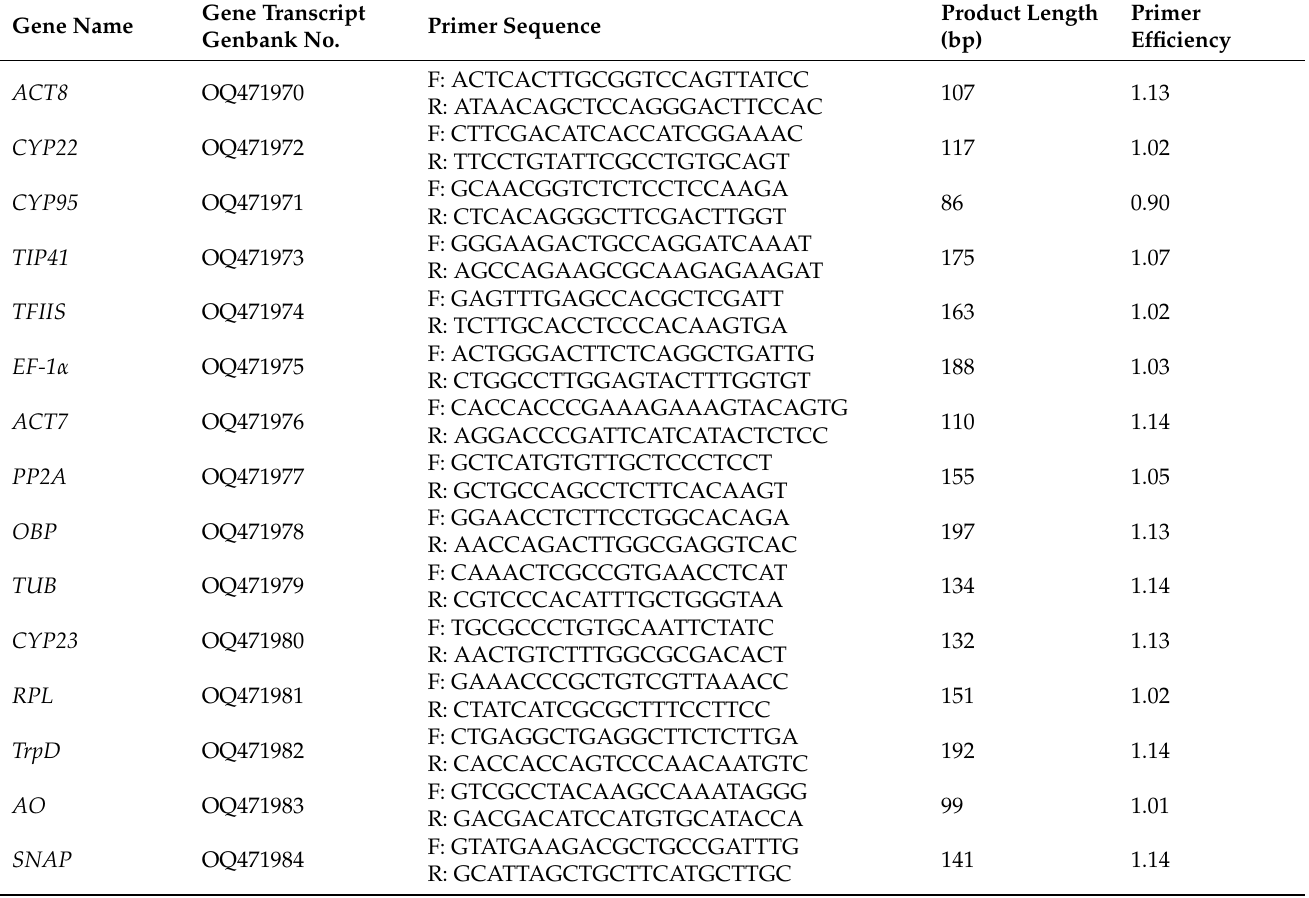
Table 2. Primer sequence information for reference genes in RT-qPCR